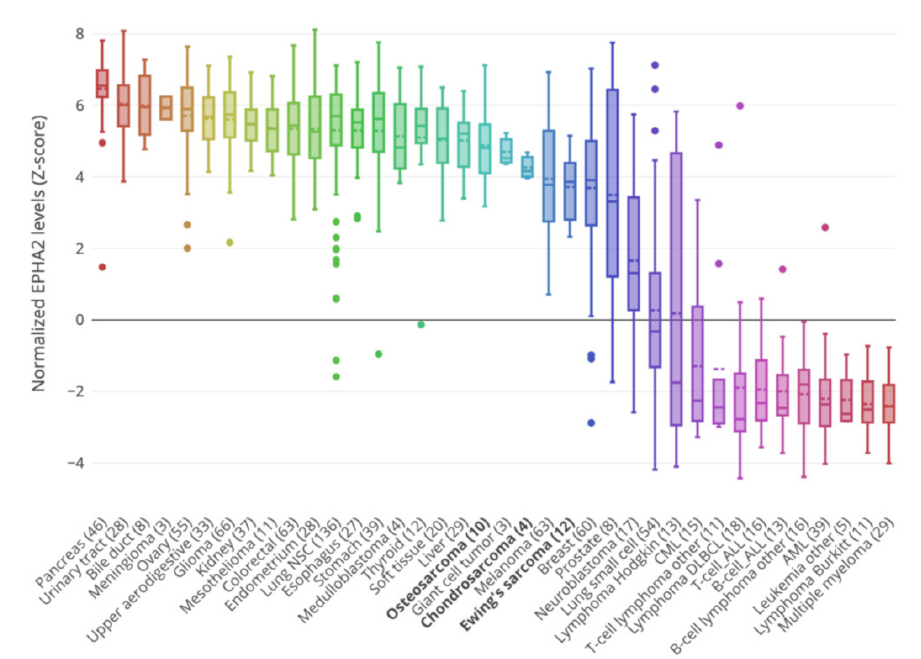
Figure 1. Distribution of EphA2 gene expression levels in the Cancer Cell Line Encyclopedia (CCLE). The box plot shows the Z-score-normalized EPHA2 levels in different cell lines divided by cancer type.